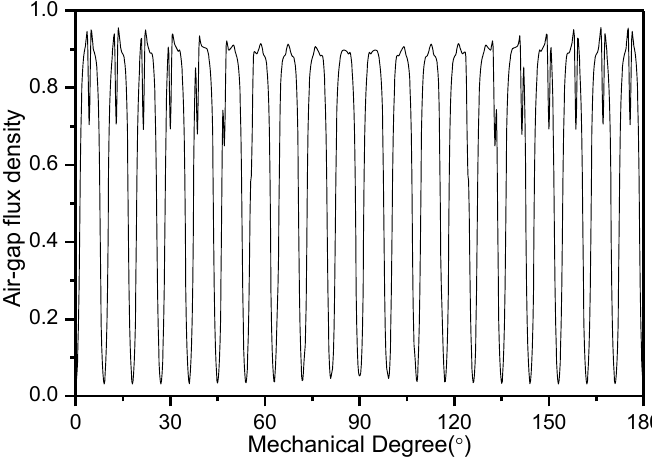
Figure 16. Air-gap flux density of the motor around the circle.